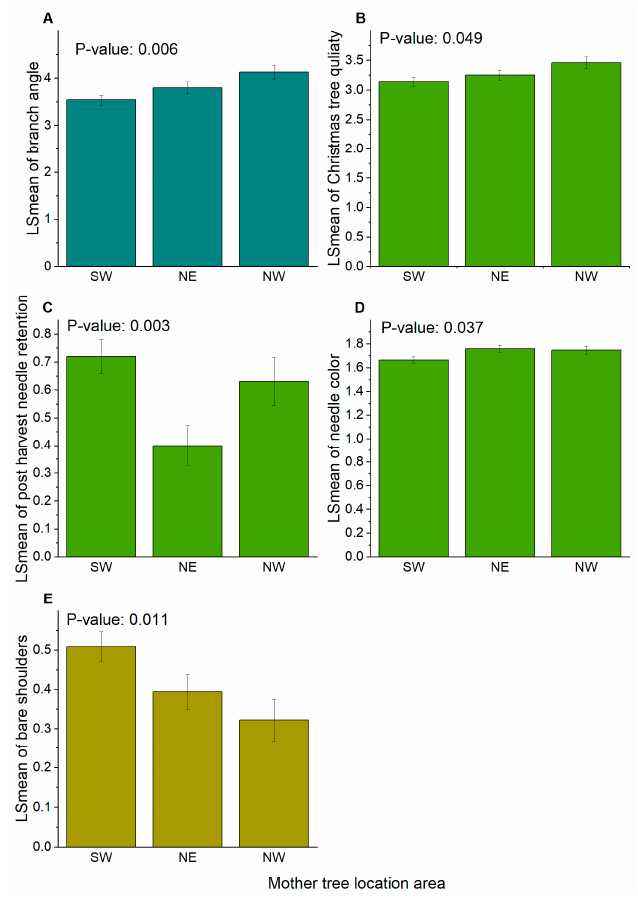
Figure 7. LSmean of the three mother tree location areas (SW, NE, NW) for ( A ) branch angle; ( B ) Christmas tree quality; ( C ) post-harvest needle retention; ( D ) needle color; ( E ) bare shoulders. The three colors indicate growth, quality, and disorder categories, respectively.